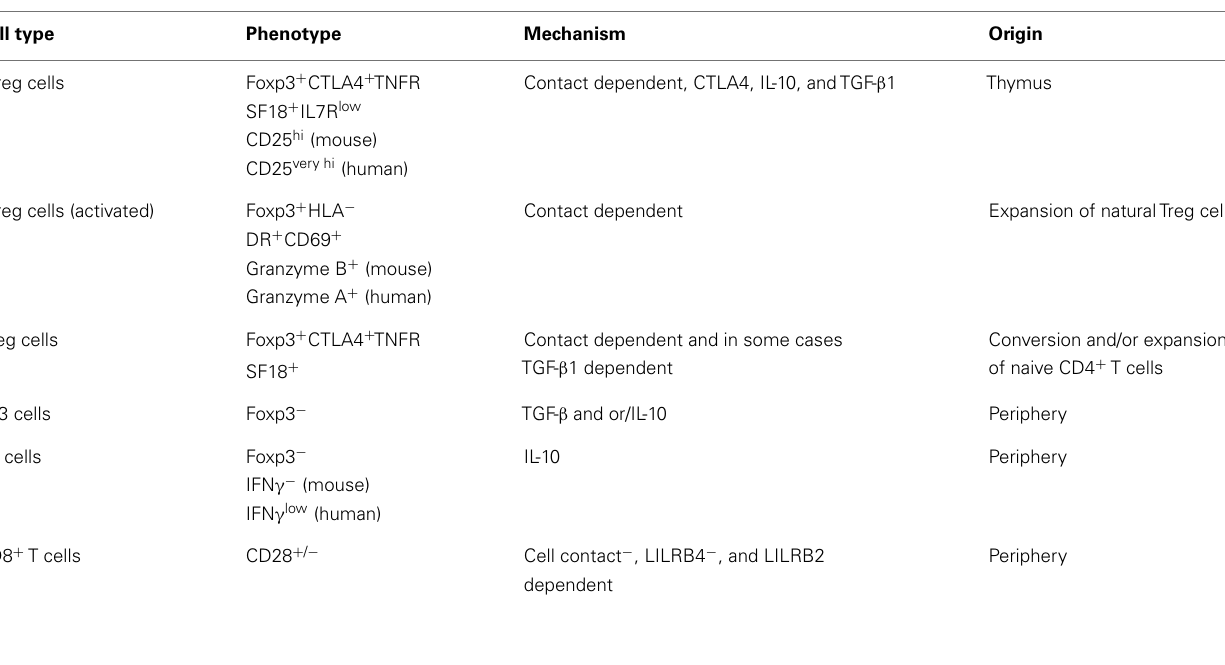
Table 1 | Characteristics of differentTreg cell subsets